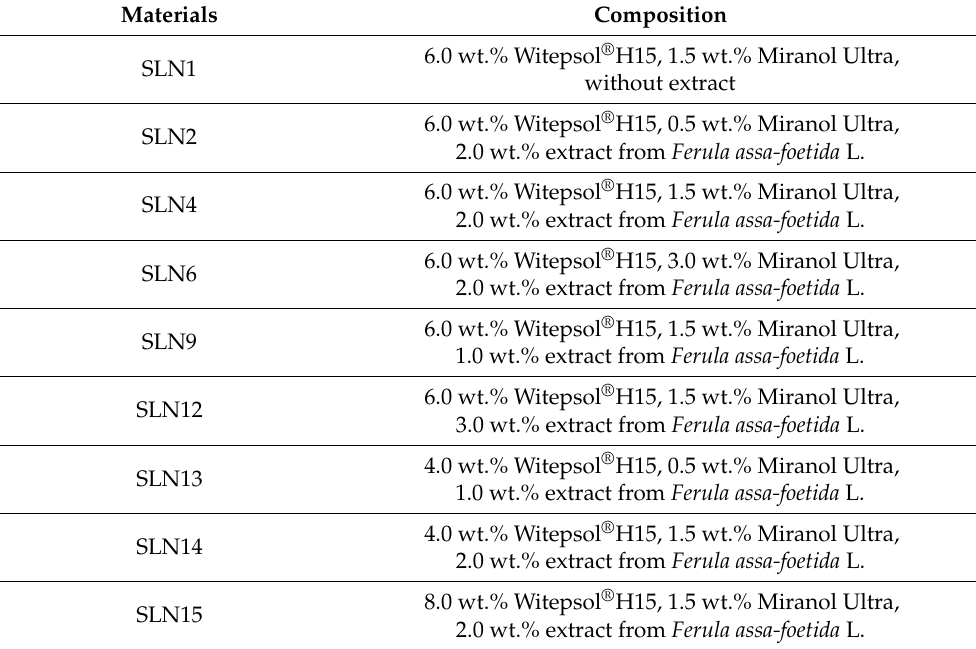
Table 3. Sample labeling mode for SLNs prepared by high-pressure homogenization.